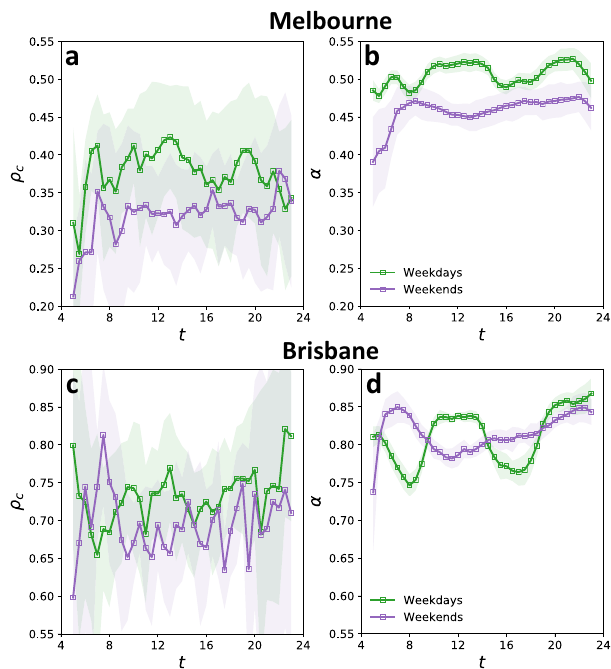
Fig. 5 Reliability of the on-road public transportation (PT) networks. a , b Temporal evolution of ρ c ( a ) and α ( b ) for Melbourne ’ s PT network, during weekdays (green) and weekends (purple). At each time t , curves show the mean, and shaded areas indicate the standard deviation of values around the mean, over September and October 2017. c , d Temporal evolution of ρ c ( c ) and α ( d ) for Brisbane ’ s network averaged over the days in March 2013, separately for weekdays and